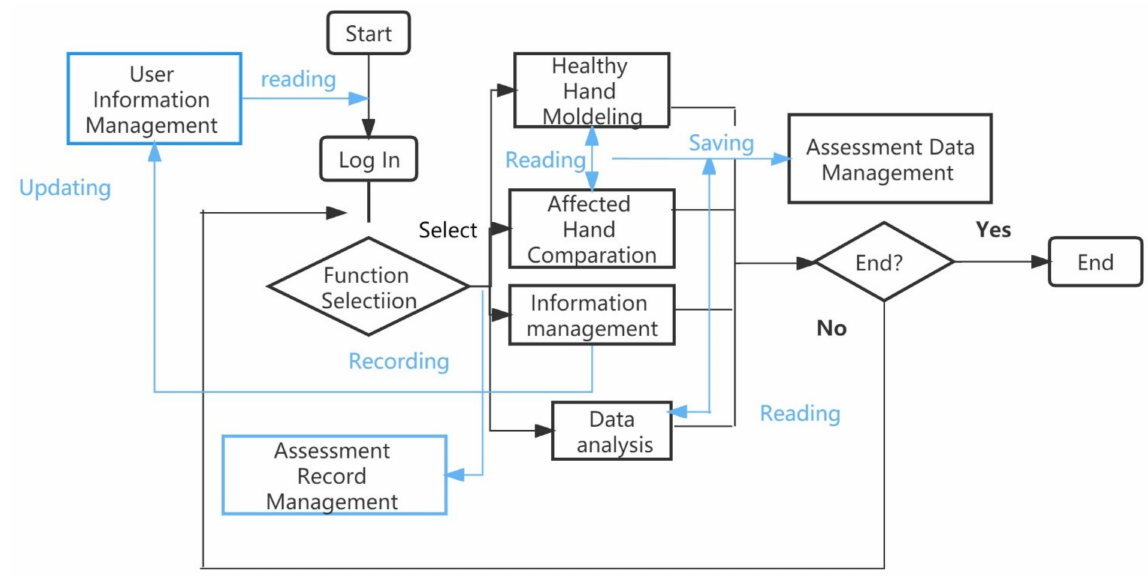
Figure 2. MDIVQAS workflow